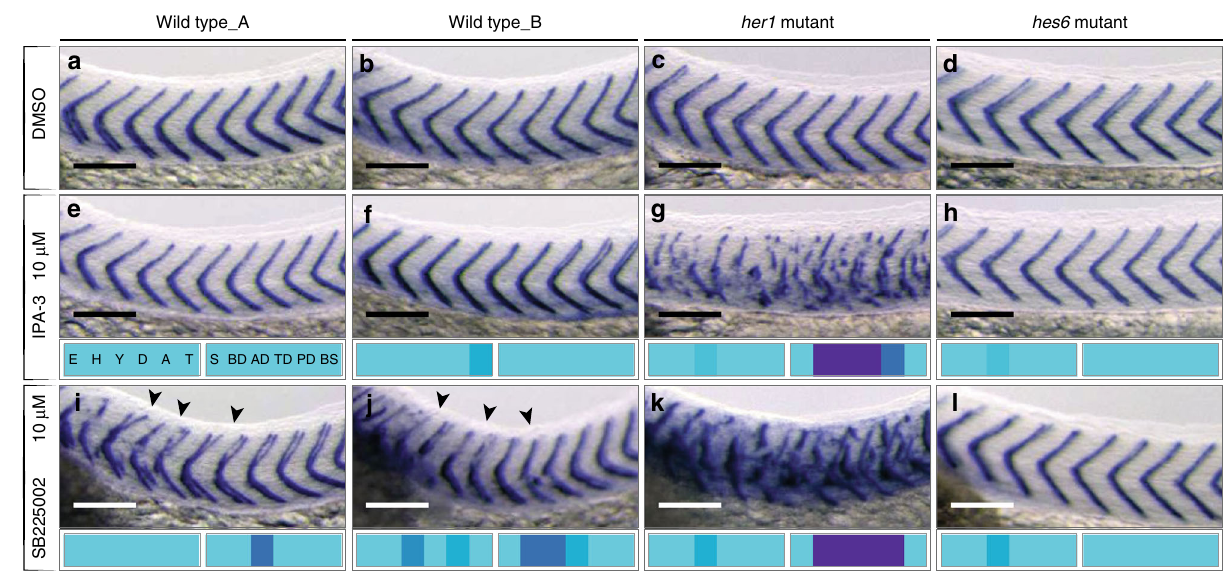
Fig. 4 Mutant background changed sensitivity to small molecule perturbation. Wild type, her1 and hes6 mutant embryos at 36 hpf after small molecule treatment as indicated, xirp2a expression in myotome boundaries shown for segments 5 – 15. a – d Myotome boundaries of each genotype normal in 0.5% DMSO control. 10 µ M IPA-3 normal segmentation in wild type replicates e , f and in the hes6 mutant h . g 10 µ M IPA-3 in her1 mutants, severe myotome boundary disruptions in trunk. i , j 10 µ M SB225002 in wild type, mild myotome boundary defects of boundaries 4 – 10 (arrowheads). k 10 µ M SB225002 in her1 mutant, severe boundary disruptions, defects extended posteriorly along axis. l 10 µ M SB225002 in hes6 mutant, no effect on myotome boundary. Embryos had otherwise normal morphology, as indicated by phenotypic vector fi ngerprints. Scale bar: 100 µ